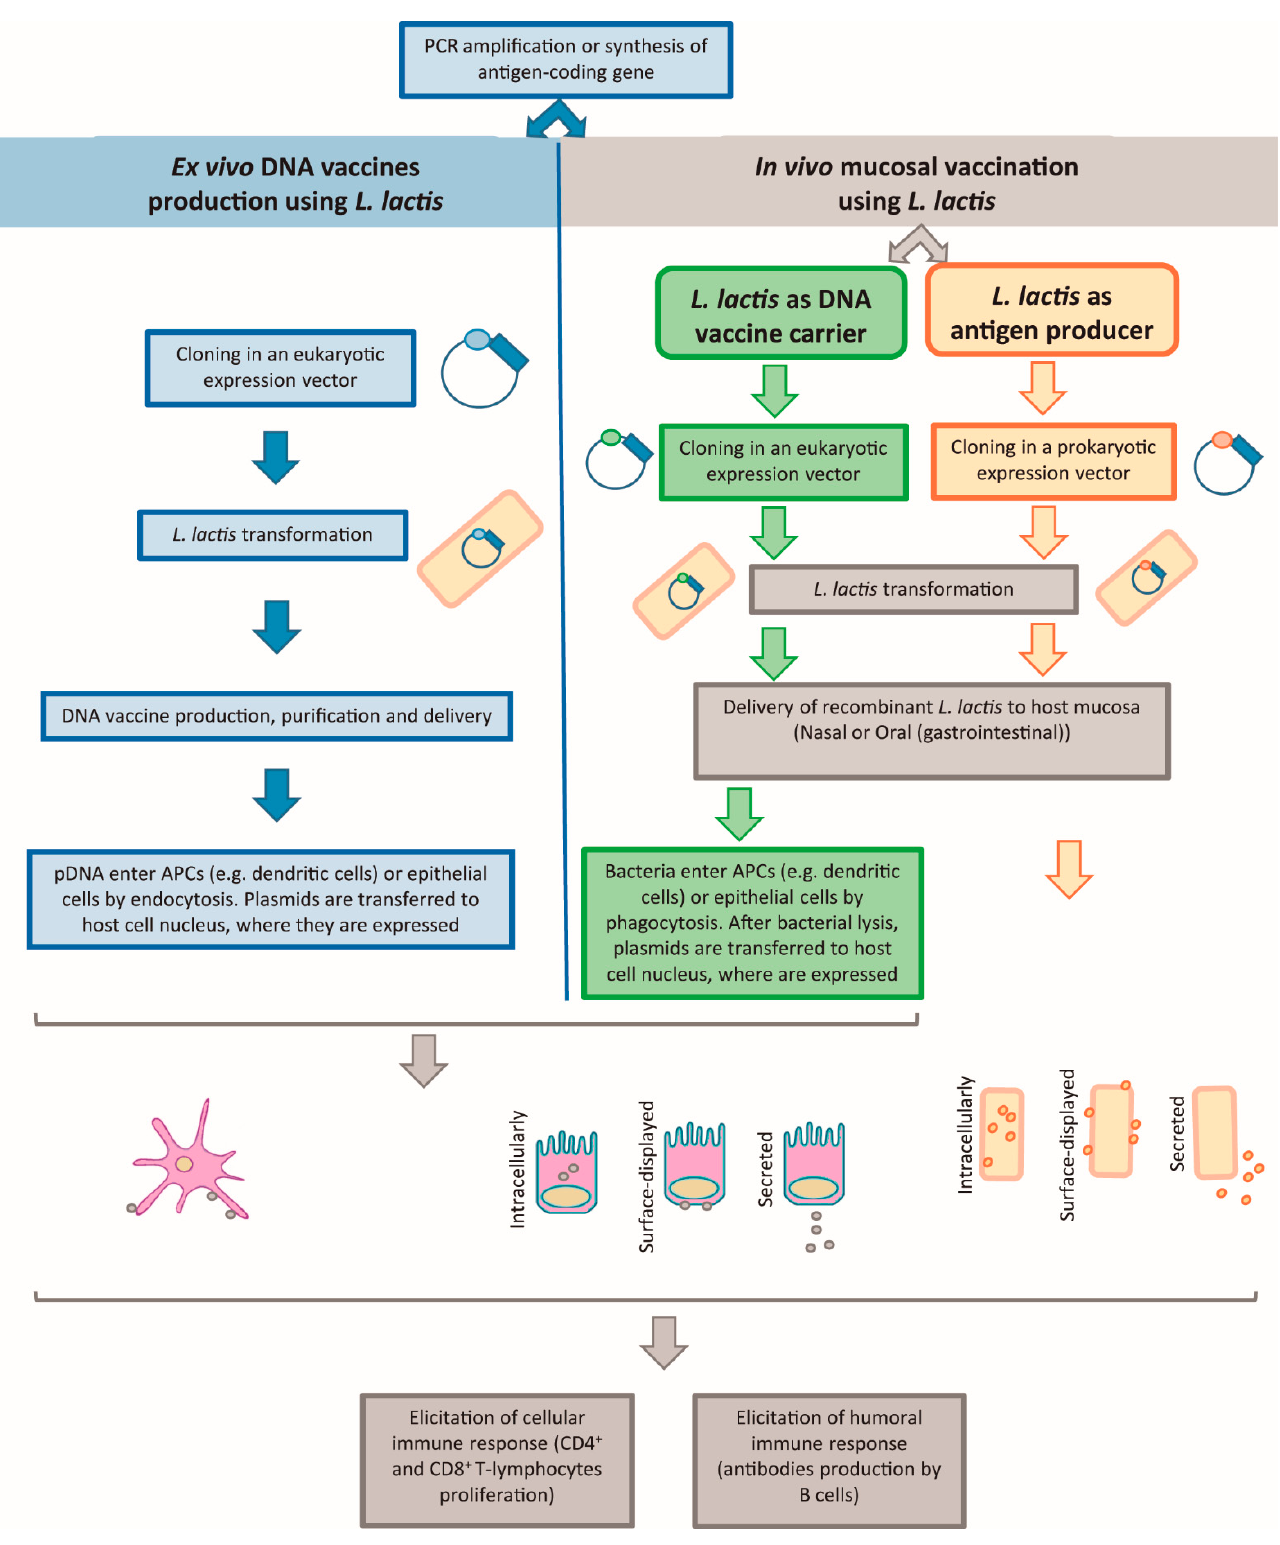
Figure 1. Comparison of the main steps of Lactococcus lactis being used as DNA vaccine producer or as delivery vector for mucosal vaccination either as a vaccine carrier or as an antigen producer [40–44]. In order to use L. lactis as a cell factory to produce naked pDNA for DNA vaccination